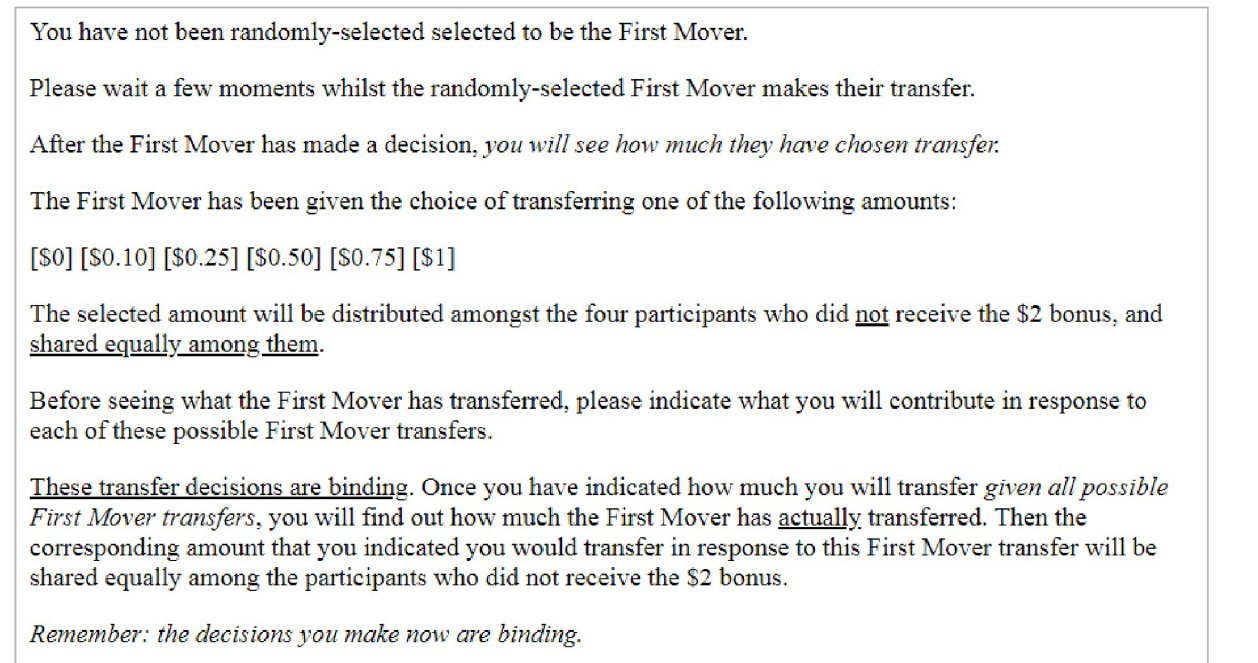
Fig 1. Screenshot showing transfer instructions for